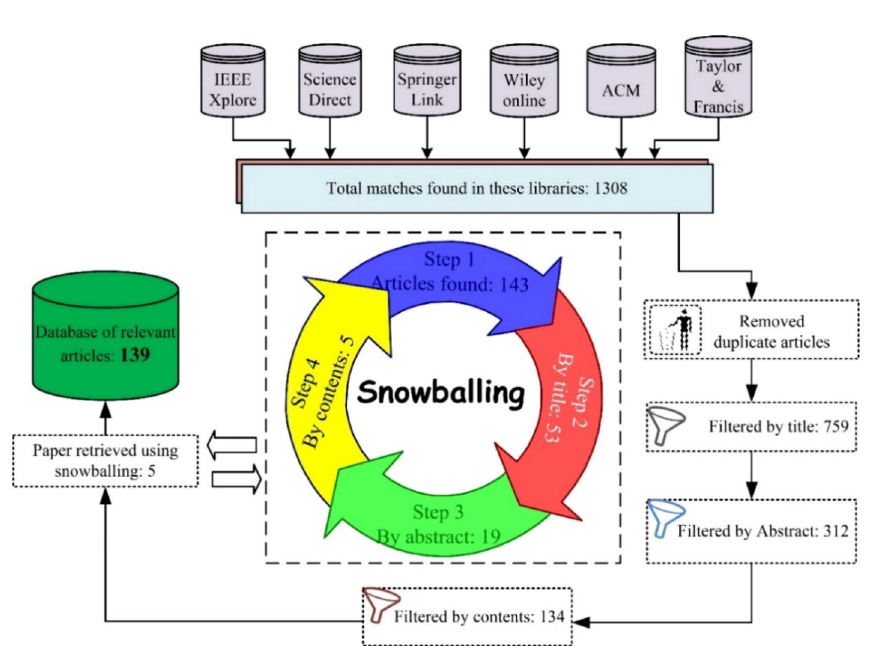
Figure 3. Extraction of each relevant article using